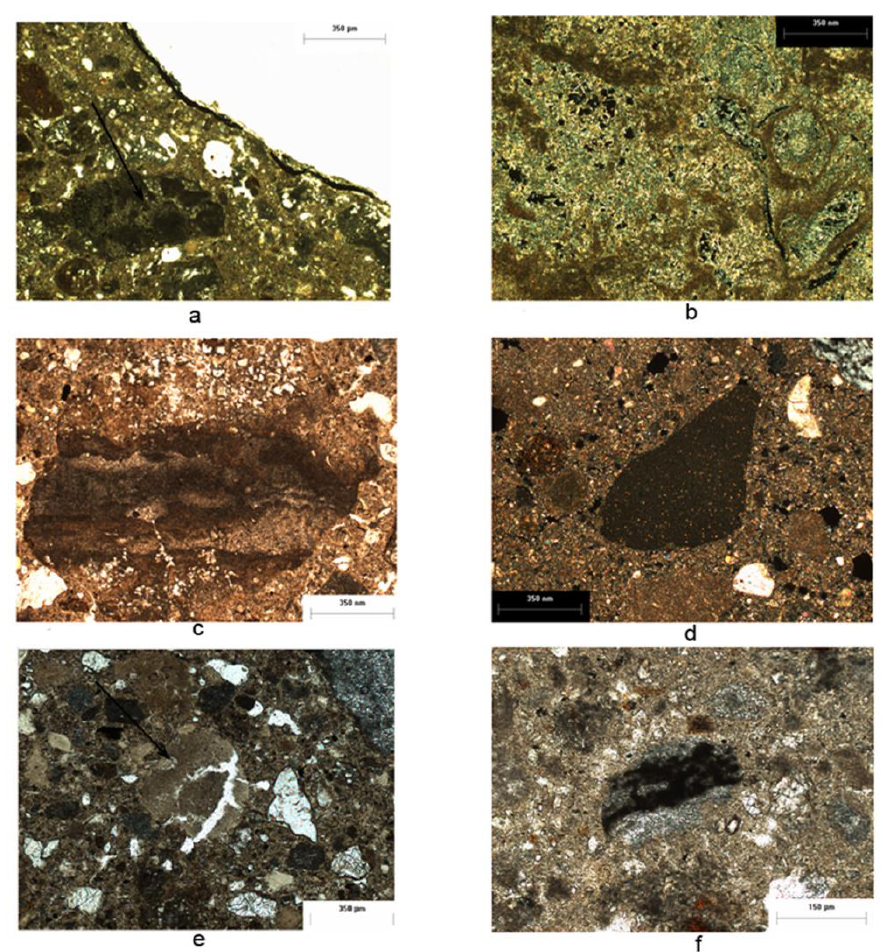
Figure 5. Micritic inclusions types. ( a ) type 1; ( b ) type 2; ( c ) type 3; ( d ) type 4; ( e ) type 5; ( f ) type 6.